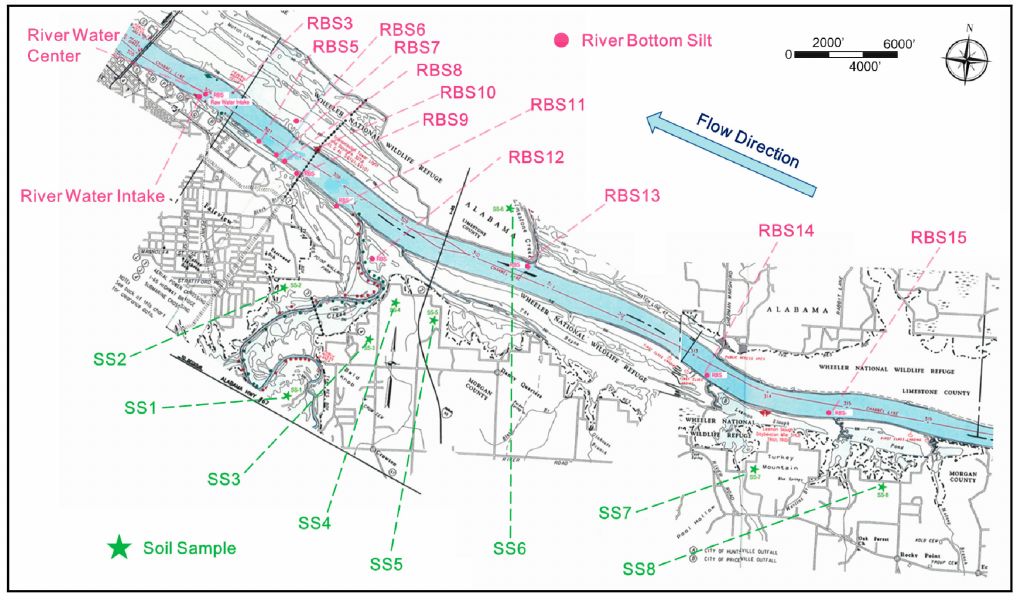
Figure 1. Sampling sites for various sediment samples along Tennessee